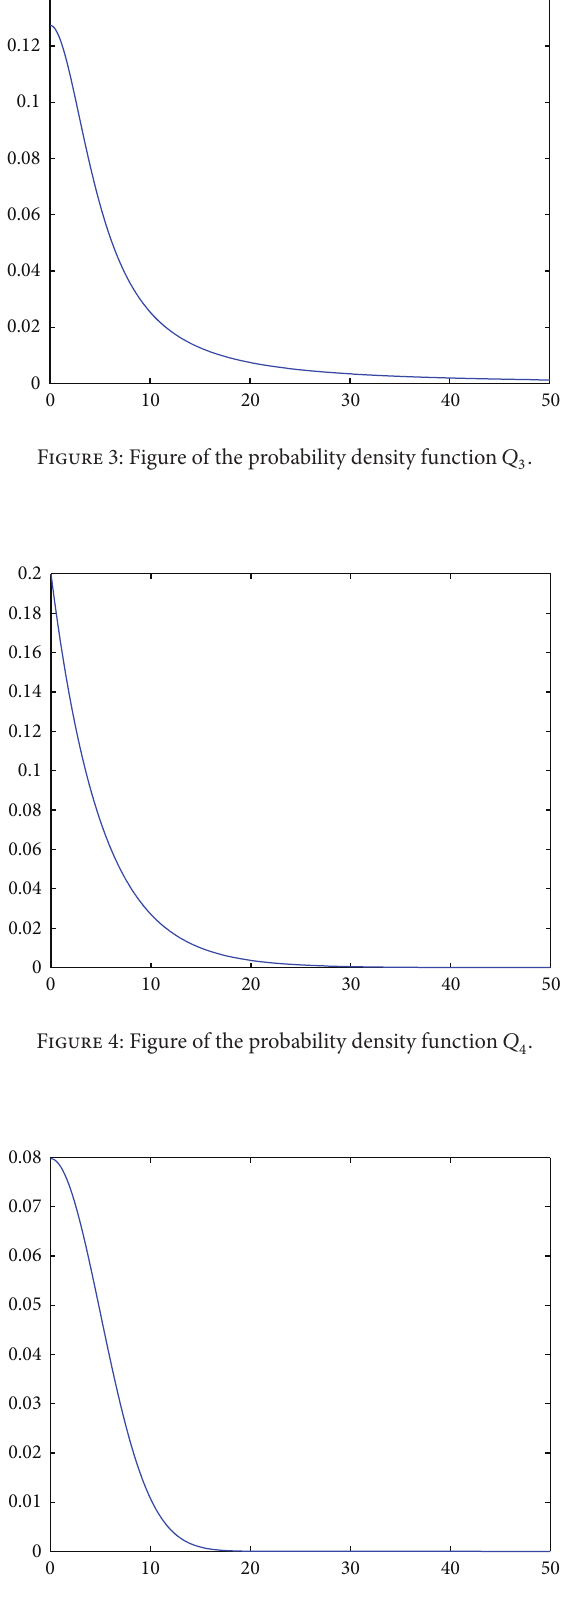
Figure 5: Figure of the probability density function 𝑄 5 .